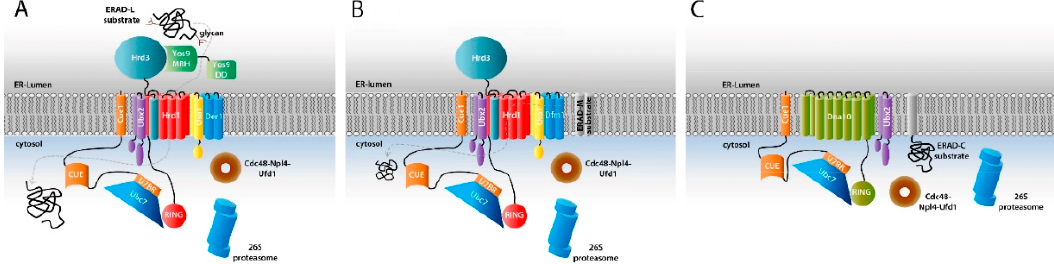
Figure 1. Schematic representation of major components of the ERAD machinery that are involved in the three main ERAD subtypes ERAD-L, ERAD-M, and ERAD-C. ( A ) The ERAD-L pathway. Panel shows the components of the Hrd1 complex that are required for degradation of targets localized within the ER lumen and additional important factors such as the AAA + ATPase Cdc48 and its two associated interaction partners Npl4 and Ufd1; ( B ) The ERAD-M pathway. Panel shows the central components and associated factors required for degradation of intra-membrane substrates. This pathway does not involve Yos9 and Der1 is exchanged with Dfm1; ( C ) The ERAD-C pathway. Panel shows the components of the Doa10 complex required for degradation of proteins with misfolded cytoplasmic domains.